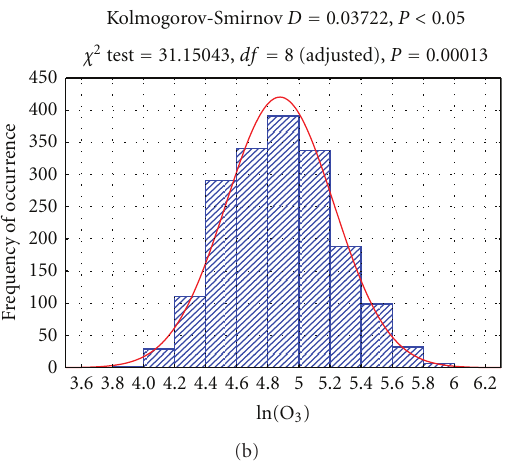
Figure 1: Normality test results for ozone (O 3 ) concentration values (a) and the natural logarithm transformation (lnO 3 ) of ozone concentrations